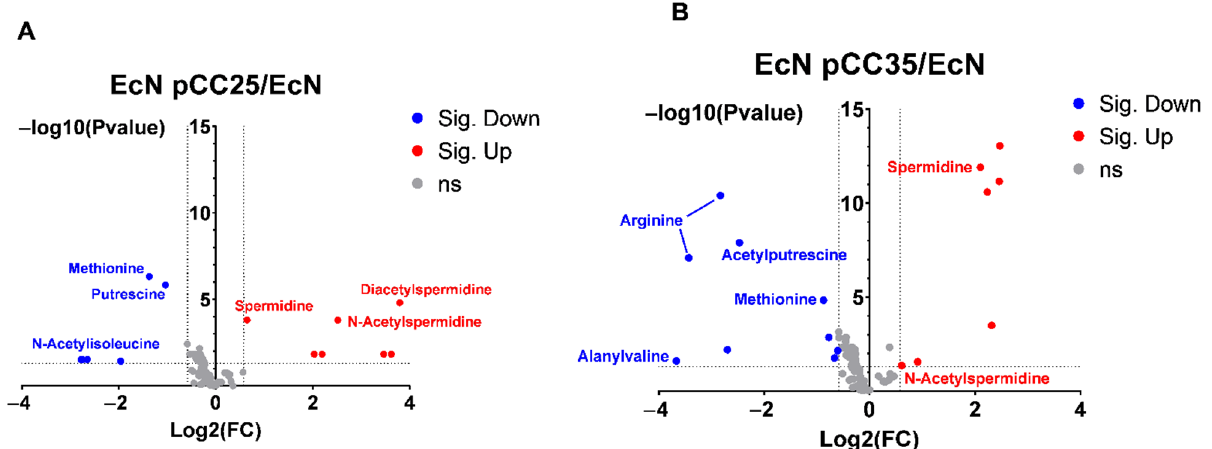
Figure 5. Volcano plot analysis of metabolic changes between EcN pCC35 and EcN pCC25 compared with EcN at 24 h of culture. ( A ) Volcano plot comparing EcN pCC25 versus EcN metabolic profile cultured in LB and collected at 24 h. ( B ) Volcano plot comparing EcN pCC35 versus EcN metabolic profile cultured in LB and collected at 24 hours. Each point on the volcano plots is based on the p -value and the fold change. Cutoff for the p -value is <0.05; fold change cutoff is >1.5 or <0.66. All p -values were adjusted using the False Discovery Rate method. All points were annotated on the graph when feature identification was possible using GNPS or SIRIUS.